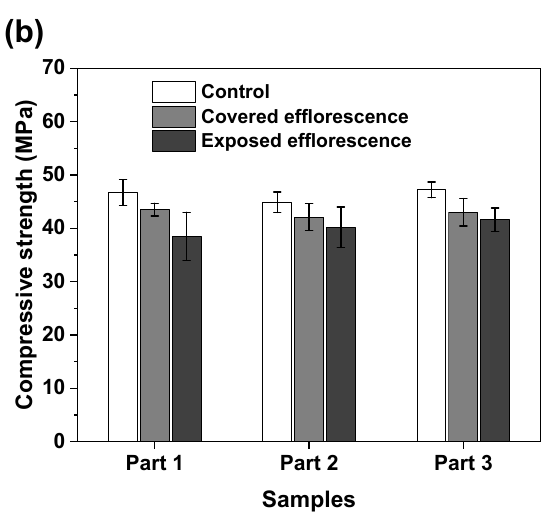
Figure 7. Compressive strengths of ( a ) NHFS and ( b ) NSFS samples.